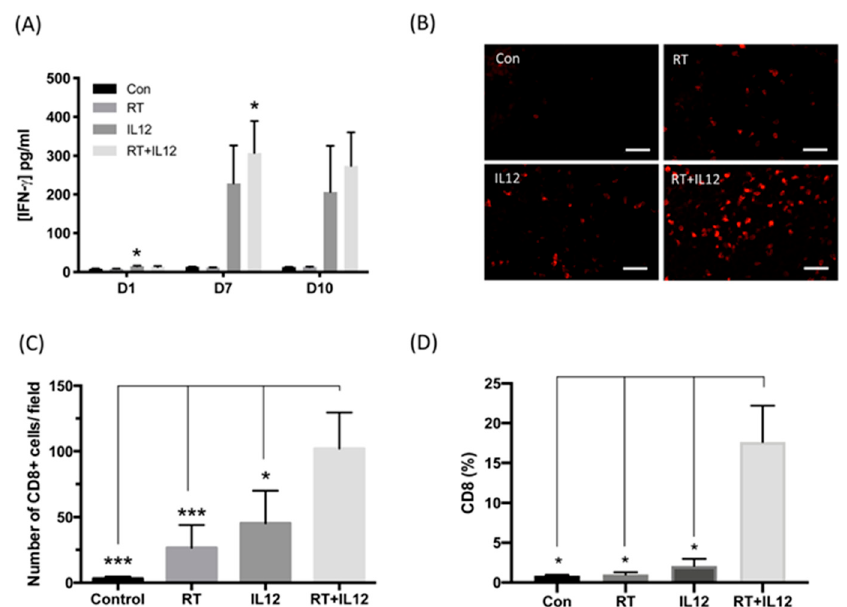
Figure 2. The anti-tumor immunity was strongly activated in combined modality treatment. ( A ) The level of IFN- γ in plasma at days 1, 7, and 10 post treatment were examined by ELISA assay. n = 3 in each group at day 1 and n = 4 in each group at days 7 and 10. ( B ) The representative figure of CD8+ T cells in tumor section of each group. Scale bar: 50 μ m. ( C ) The number of CD8+ T cells was quantified by counting the positive signal under 400× magnification field in each section. Each section had at least 10 fields for quantification. Each group had at least three samples. ( D ) The population of CD8+ T cells in tumor cell suspension was analyzed by flow cytometry. n = 4 in control, RT, and IL-12 groups. n = 7 in RT+IL-12 group. * p < 0.05, *** p < 0.001.